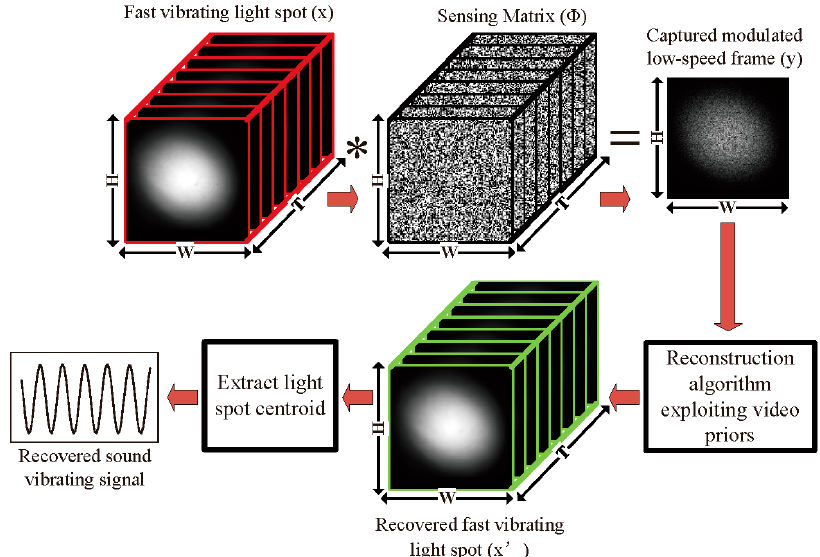
Figure 1. The schematic diagram of a compressive camera for sound detection. The forward sensing model includes a light spot video ( x ) consisting of T frames, with H × W pixels each, which is multiplied by T sampling patterns embedded within the sensing matrix Φ . The CCD (charge-coupled device) camera integrates over the exposure time, producing a single modulated image y consisting of H × W pixels. In the backward model, the algorithms based on compressive sensing are used to reconstruct the fast light spot video from the modulated images. Finally, the centroids of the reconstructed light spots are used to recover the sound.